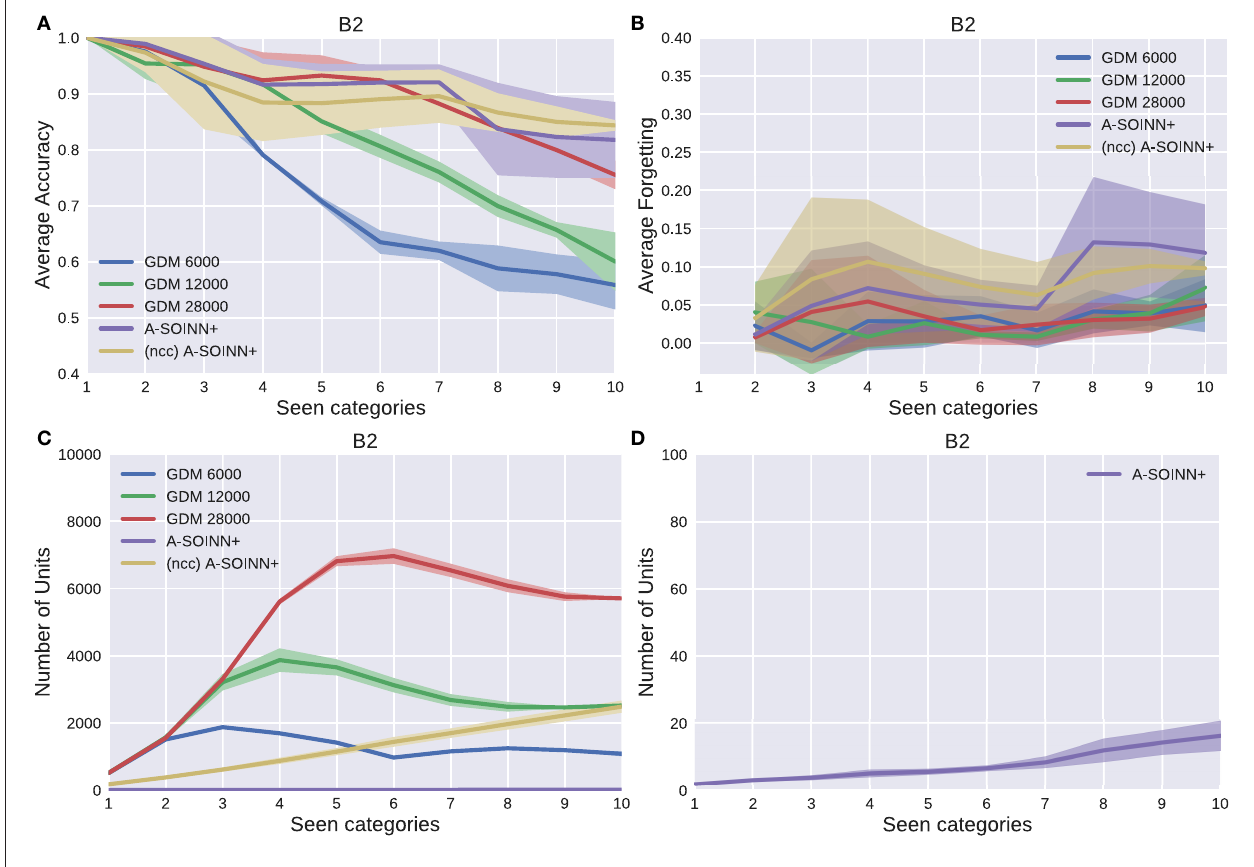
FIGURE 6 | The results of the second experiment. For further descriptions, see Figure 5